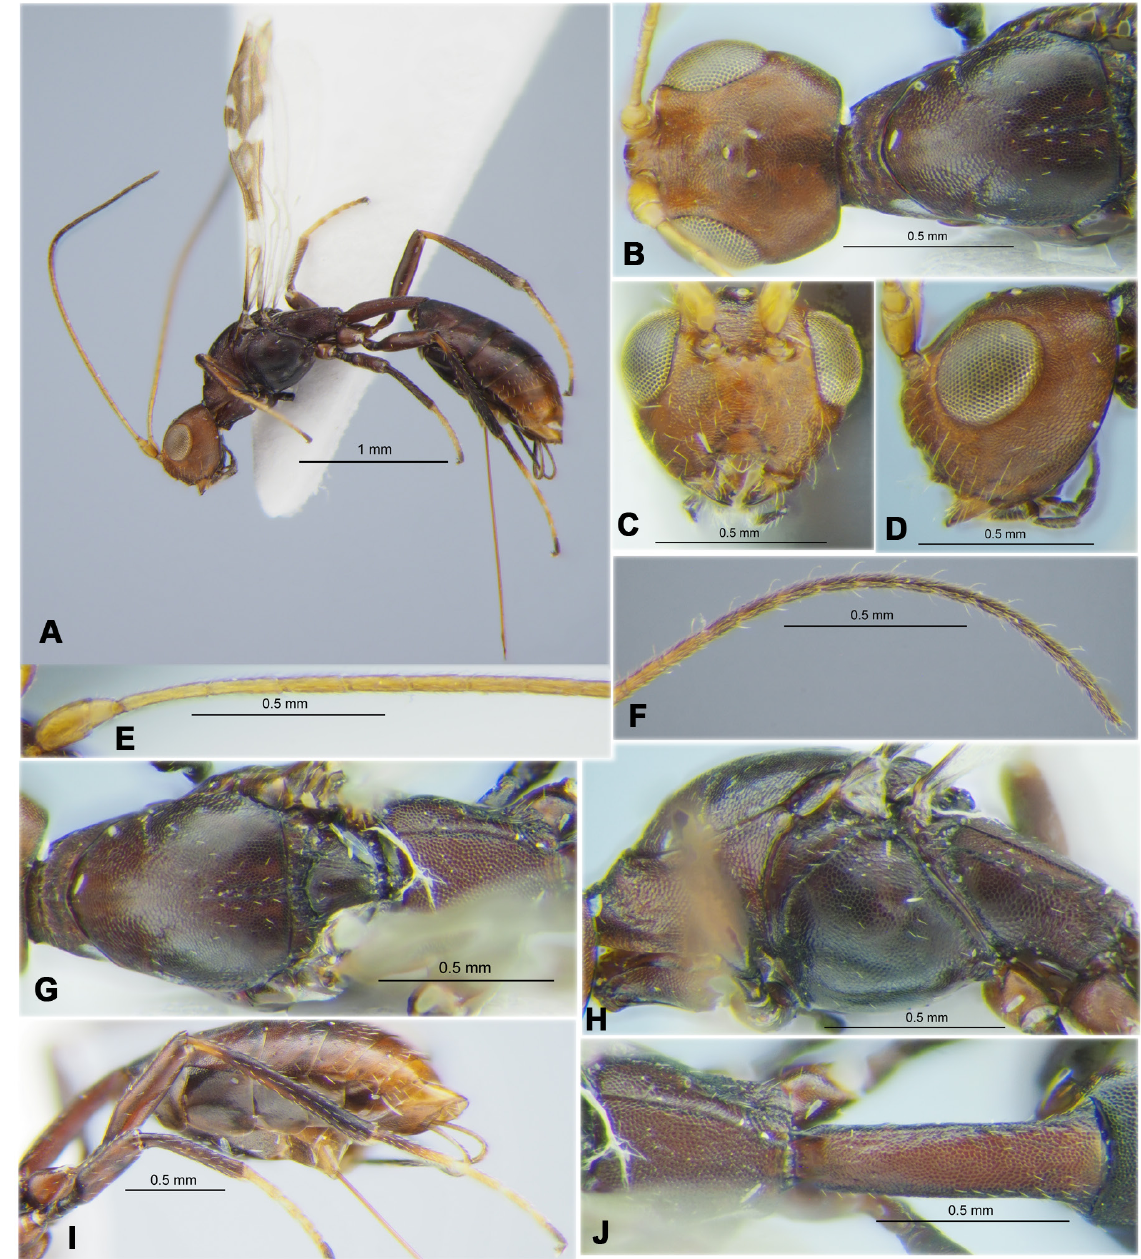
Fig. 14. Parana arabica Belokobylskij sp. nov., holotype, ♀ (RMNH). A . Habitus, lateral view. B . Head and mesoscutum, dorsal view. C . Head, front view. D . Head, lateral view. E . Basal segments of antenna. F . Apical segments of antenna. G . Mesosoma, dorsal view. H . Mesosoma, lateral view. I . Hind leg. J . Propodeum and petiole of metasoma, dorsal